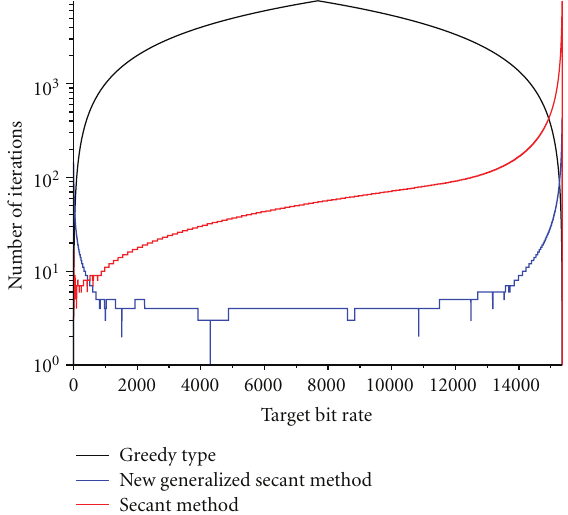
Figure 4: Number of iterations of the bisection and secant methods, and greedy-type algorithm for integer-bit solution versus target bitrate, n = 1024, r max =